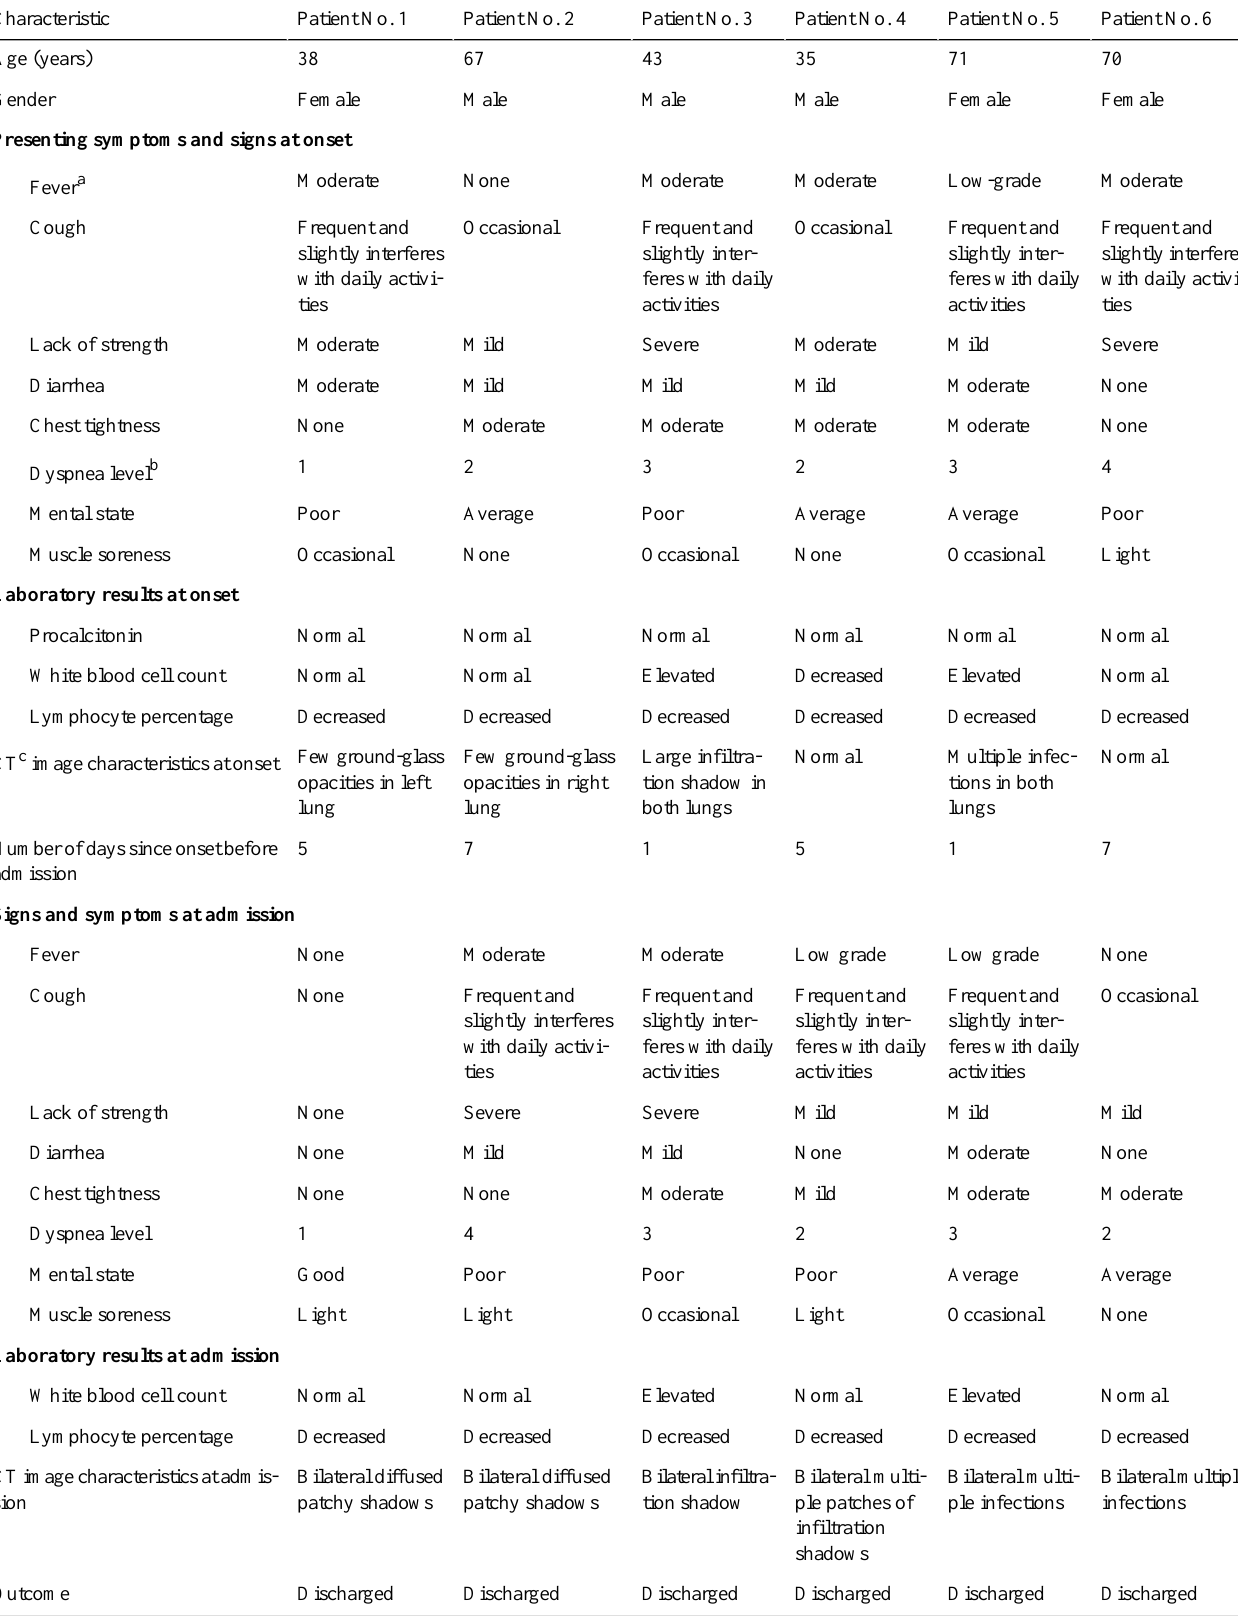
Table 2. Clinical characteristics of the participating patients admitted to hospital (n=6) based on the medical observation scales described in Multimedia Appendix